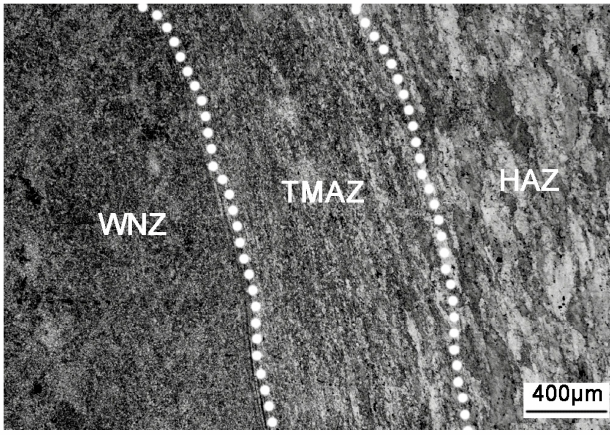
Figure 7. Microstructure of the FSW joint.